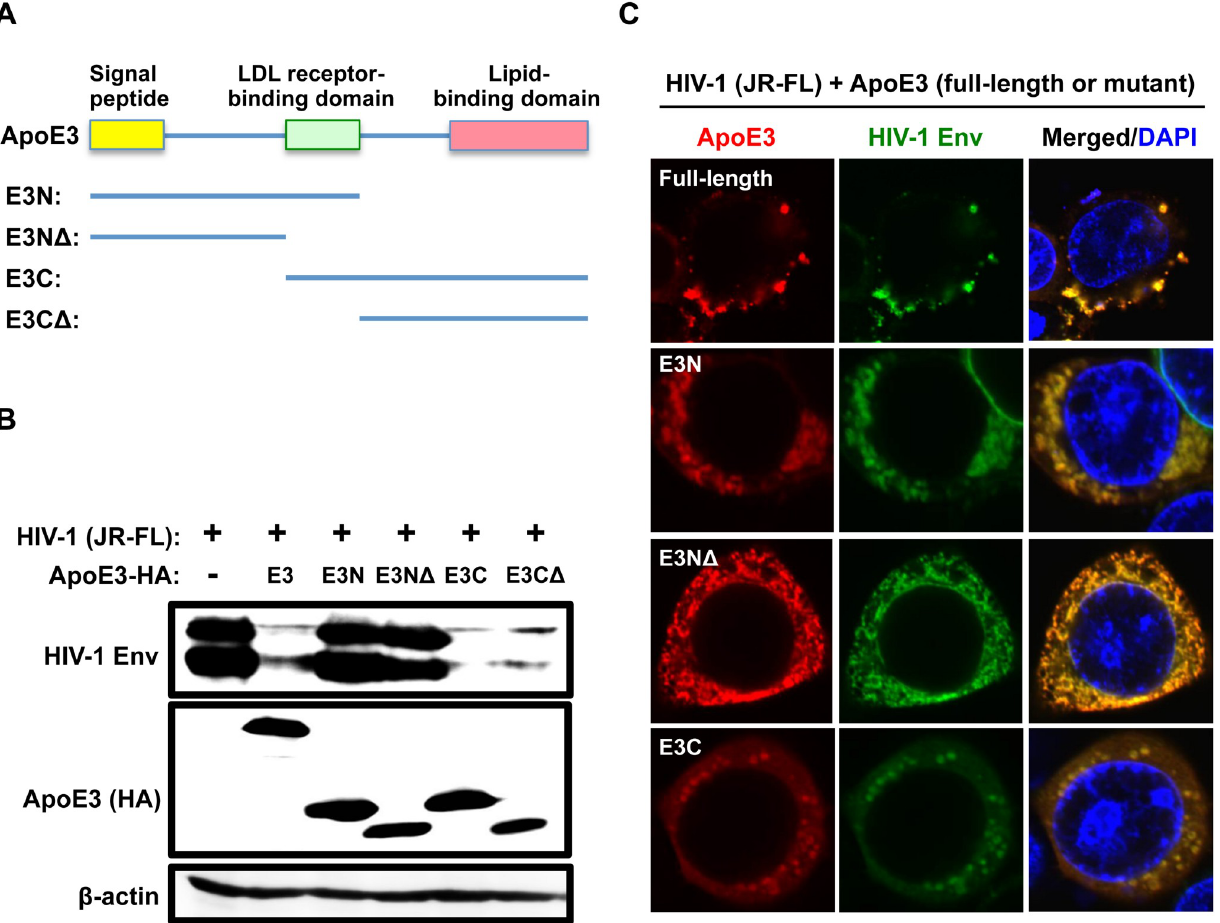
Fig 7. Effects of ApoE3 mutants on Env expression and localization in 293T cells. (A) Schematic representation of ApoE3 protein structure and the deletion mutants (E3N, E3N Δ , E3C and E3C Δ ). ApoE has three functional domains: the N-terminal signaling domain, the LDL receptor-binding domain, and the C-terminal lipid-binding domain. (B) The 293T cells were transfected with 2 μ g of the HIV-1 molecular clone JR-FL, or co-transfected with 2 μ g of the HA-tagged full-length ApoE3 (E3) or the indicated mutant expression vector. The cells were then lysed, and subjected to western blot to analyze the expression of Env. ApoE expression was verified using anti-HA antibody. Anti- β -actin blot was used as a loading control. (C) The 293T cells were co- transfected with 100 ng of the HIV-1 molecular clone JR-FL and 100 ng of the indicated ApoE3 expression vector. Twenty-four hours post-transfection, the cells were stained with anti-HIV-1 Env and anti-HA antibodies, and the signals were visualized with AlexaFluor488 goat anti-Human IgG and AlexaFluor594 donkey anti-mouse IgG. Nuclei were stained with DAPI (blue). Original magnification x600.